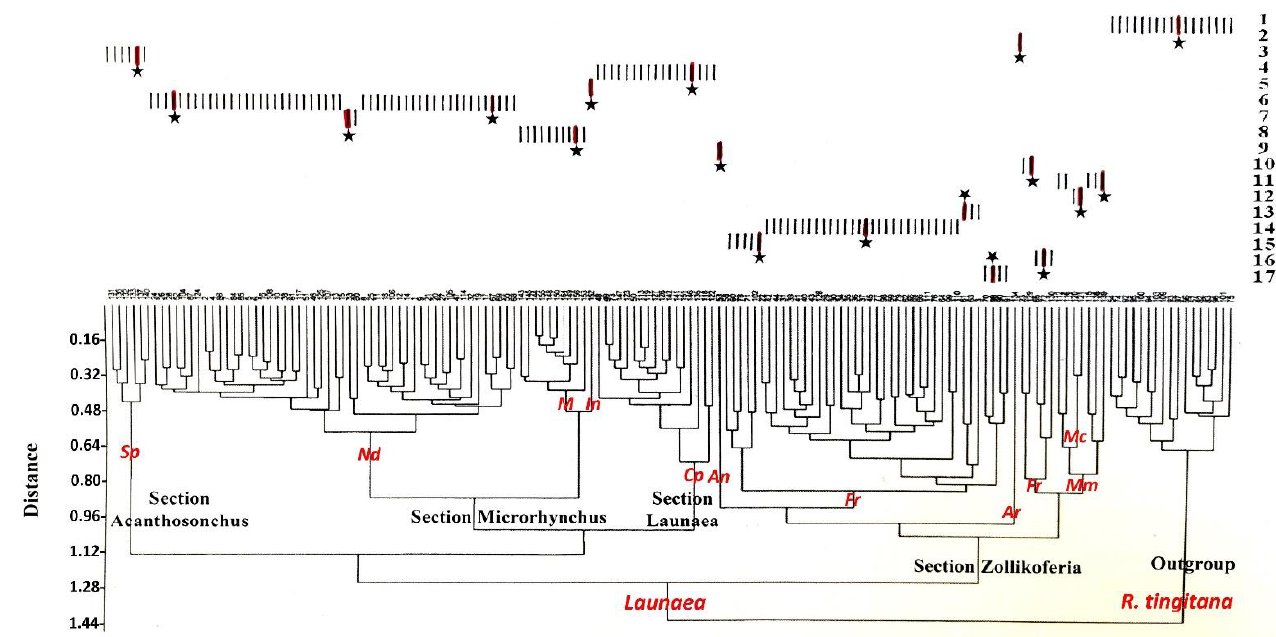
Figure 4. Dendrogram using the UPGMA method of sorting for the 156 specimensof Launaea and Reichardia tingitana . 1, R. tingitana ; 2, ( Ar ) L. angustifolia subsp. arabica ; 3, ( Sp ) L. spinosa ; 4, ( Cp ) L. capitata ; 5, ( In ) L. intybacea ; 6 – 7, ( Nd ) L. nudicaulis ; 8, ( M ) L. massauensis ; 9, ( An ) L. angustifolia subsp. angustifolia ; 10, ( Fr ) L. fragilis subsp. fragilis ; 11, ( Mm ) L. mucronata subsp. mucronata ; 12, ( Mc ) L. mucronata subsp. cassiniana ; 10, 13 – 17, ( Fr ) L. fragilis subsp. fragilis . Stars indicate the studied specimens for achene and pollen grain micromorphological attributes.